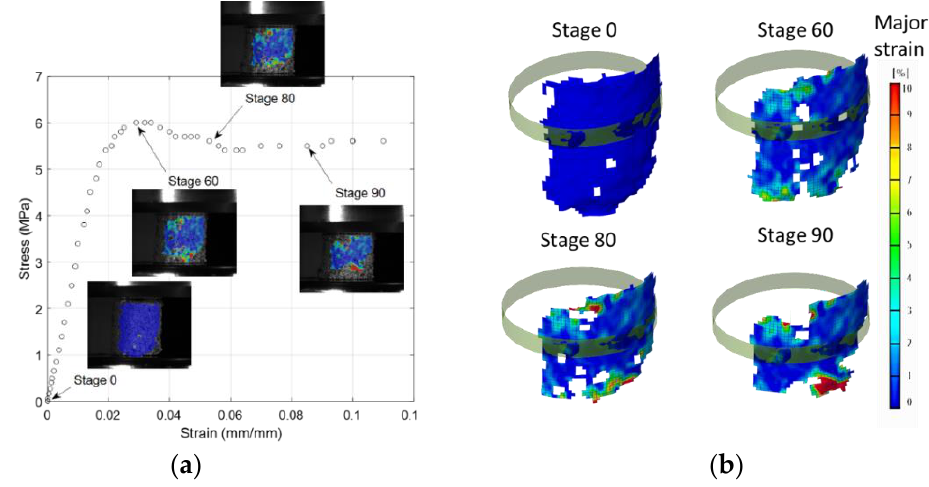
Figure 5. Images from a uniaxial compression test using digital image correlation (DIC) techniques: ( a ) different stages; ( b ) cylinder shape approximation.